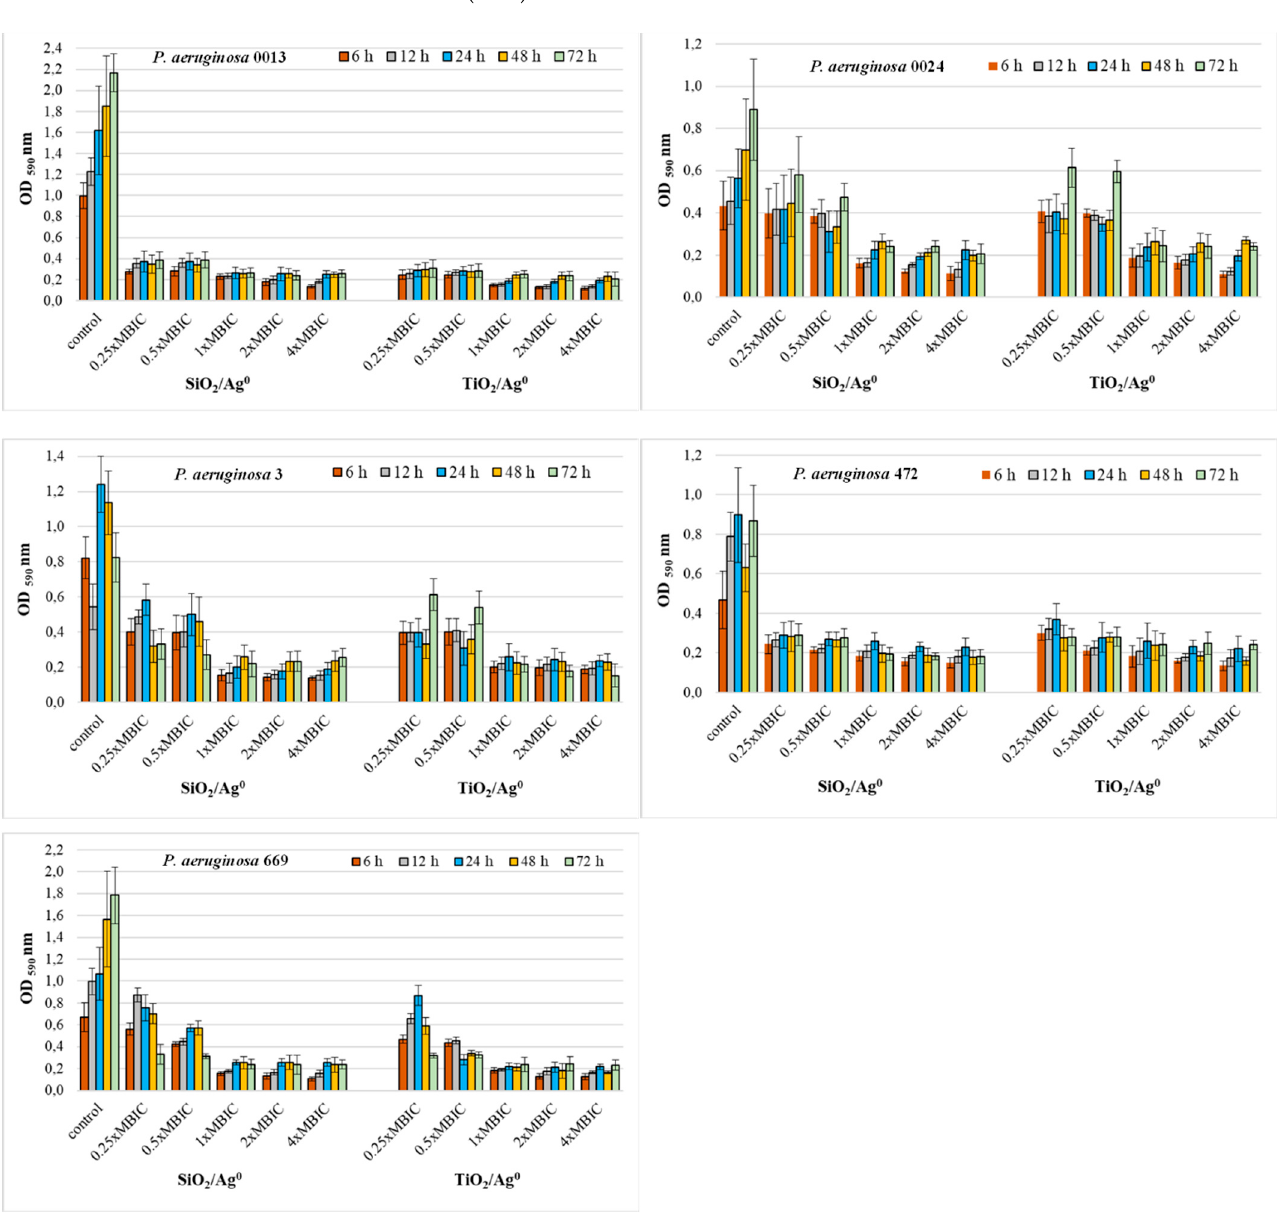
Figure 5. Effect of SiO 2 /Ag 0 and TiO 2 /Ag 0 on biofilm formation by P. aeruginosa strains isolated from bronchoalveolar lavage fluid. Interpretation of the results: OD ≤ 0.096—non-biofilm producer; 0.096 < OD ≤ 0.192—weak-biofilm producer; 0.192 < OD ≤ 0.384—moderate-biofilm producer; OD > 0.384—strong-biofilm producer.